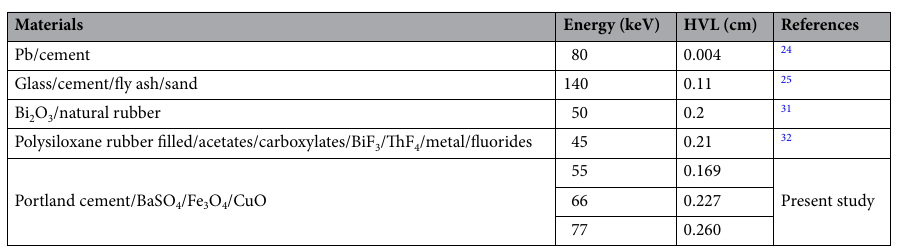
Table 3. Half value layer (HVL) in this study and the previous published references for comparison.